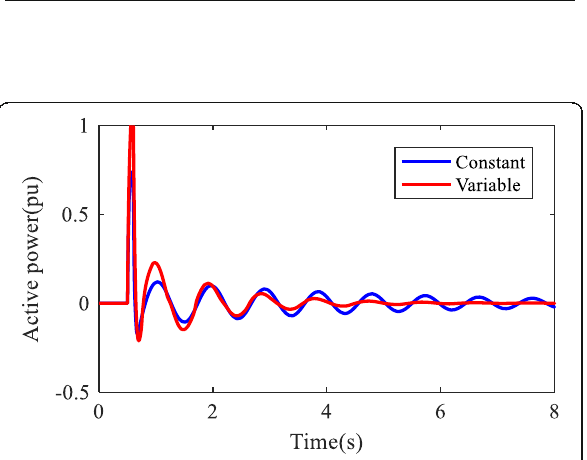
Fig. 17 The Active power output of ESS when the output power of the PV is 0.09